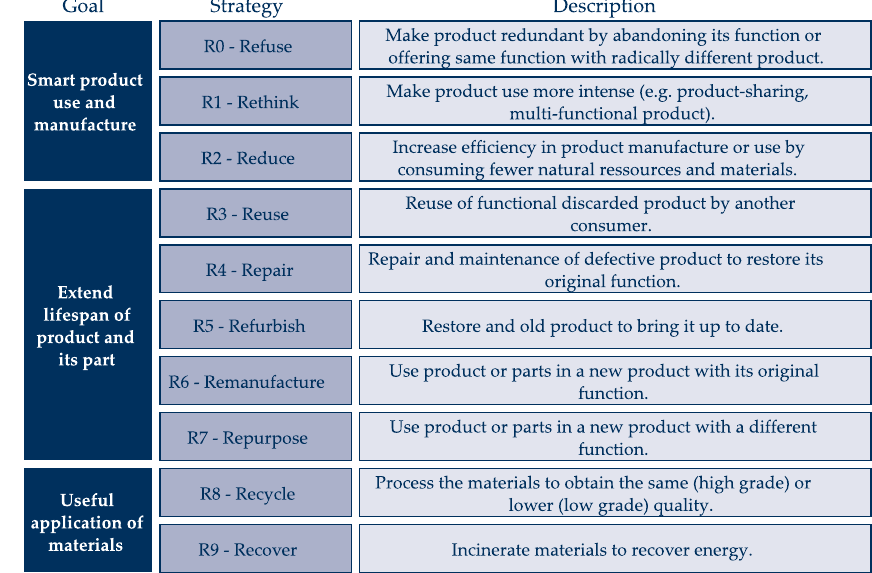
Fig. 4 10 R-strategies ordered for priority according to their levels of circularity [23]